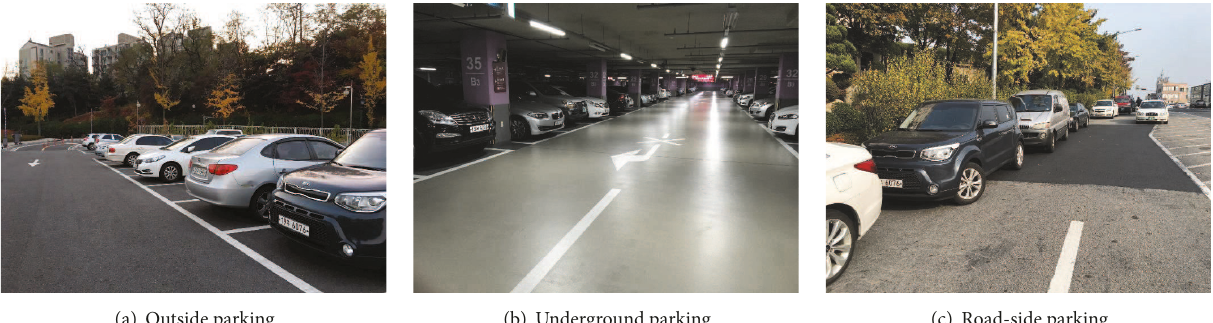
Figure 4: Three different environmental conditions.